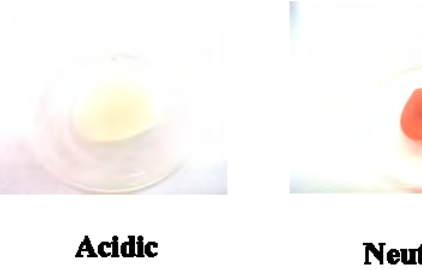
Figure 4. Colors of 5b on PC film under acidic (exposed to HCl(g)), neutral and basic (exposed to NH (g)) 3